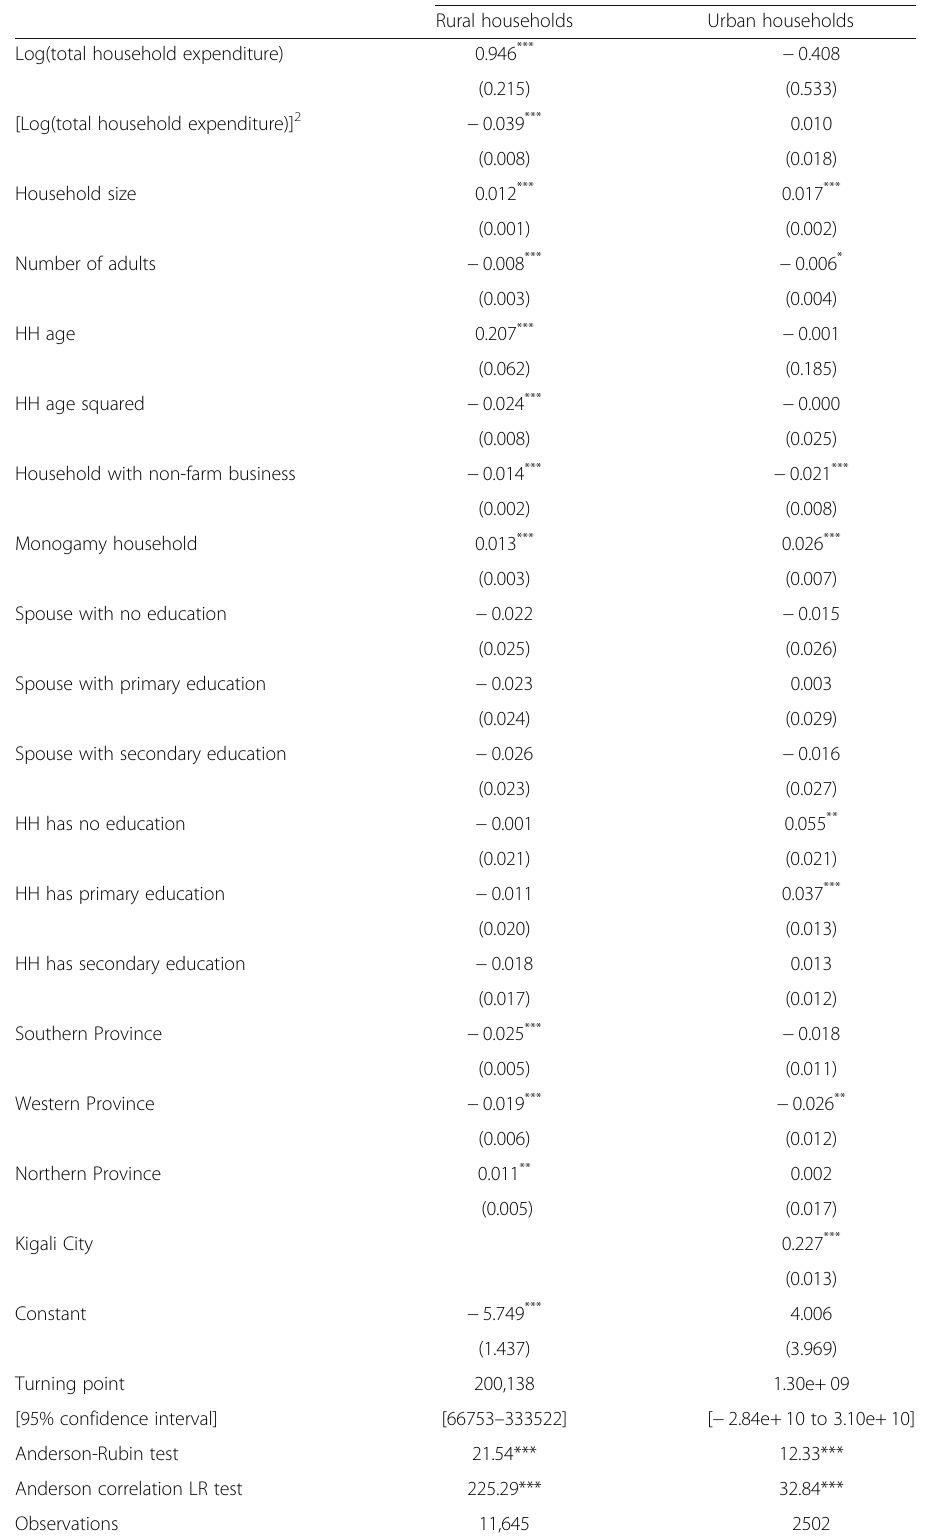
Table 3 Estimated W-L model for food consumption: first upper